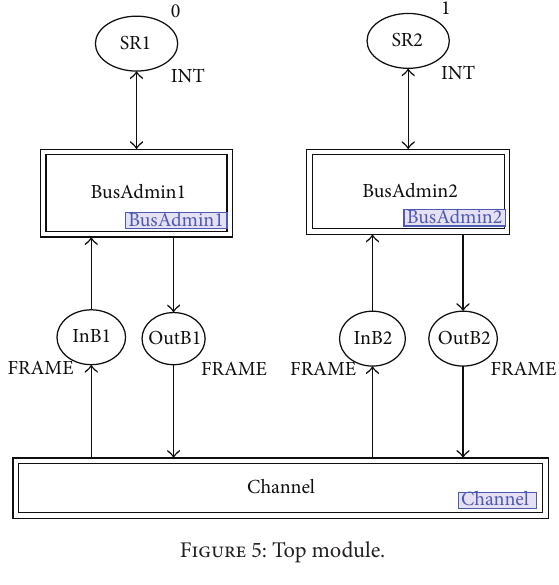
Table 2: Input and output signals corresponding with its FID.